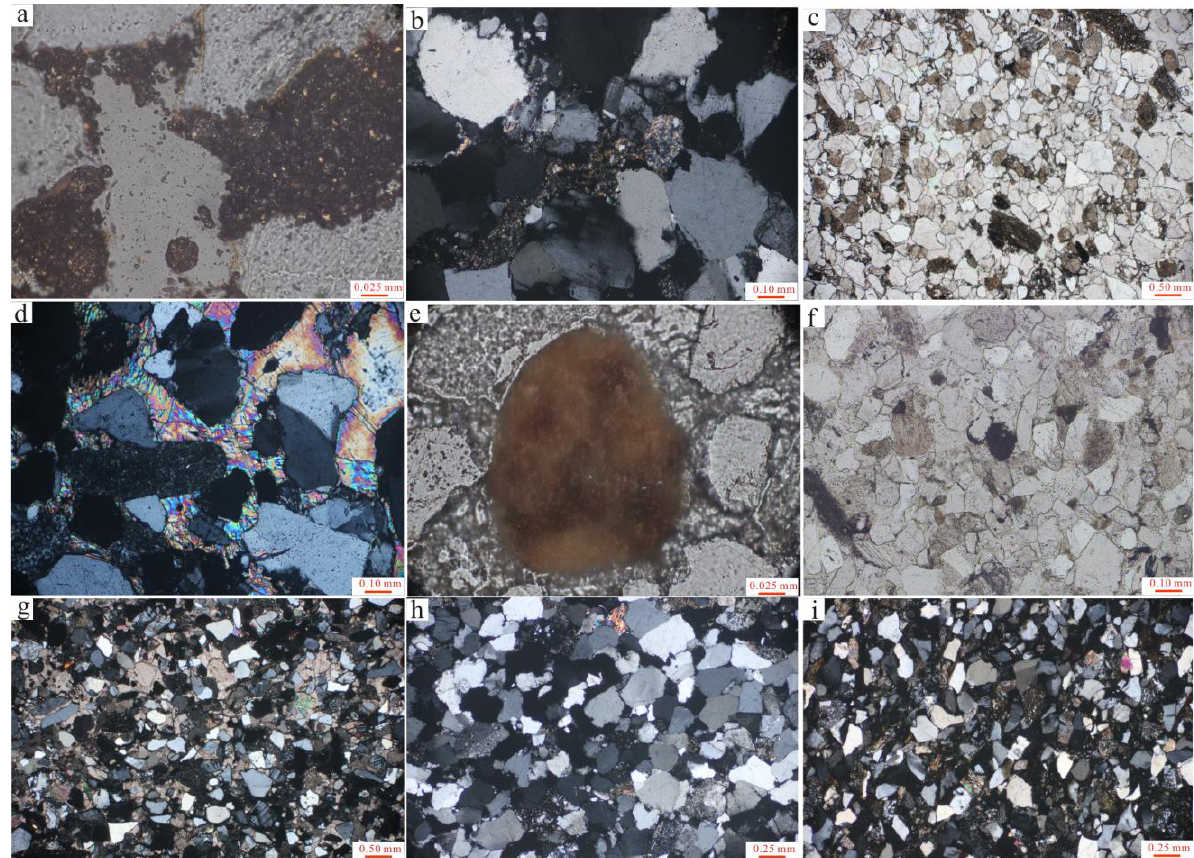
Figure 4. Representative photomicrographs of Zhiluo Formation Sandstone. ( a ) From well ZkS01 at 1938.6 m, light yellowish white pyrite, plane-polarised light 40 × . ( b ) From well ZkS01 at 1933.3 m, line–point contact, crossed-polarised light, 10 × . ( c ) J 2 z 1-2 , Linyou area, chlorite and calcareous cement, plane-polarised light, 2 × . ( d ) J 2 z 2 , Linyou area, secondary gypsum, crossed-polarised light, 10 × . ( e ) J 2 z 2 , Linyou area, limonite, reflected light, 40 × . ( f ) From well ZkS01 at 1715.2 m, chlorite and calcareous and iron cements, plane-polarised light, 10 × . ( g ) J 2 z 1-2 , Shenshangou area, feldspar sandstone, crossed-polarised light, 2 × . ( h ) From well ZkS01 at 1928.6 m, quartz sandstone, crossed-polarised light, 4 × . ( i ) J 2 z 1-1 , Fuxian area, feldspar sandstone, crossed-polarised light, 4 ×